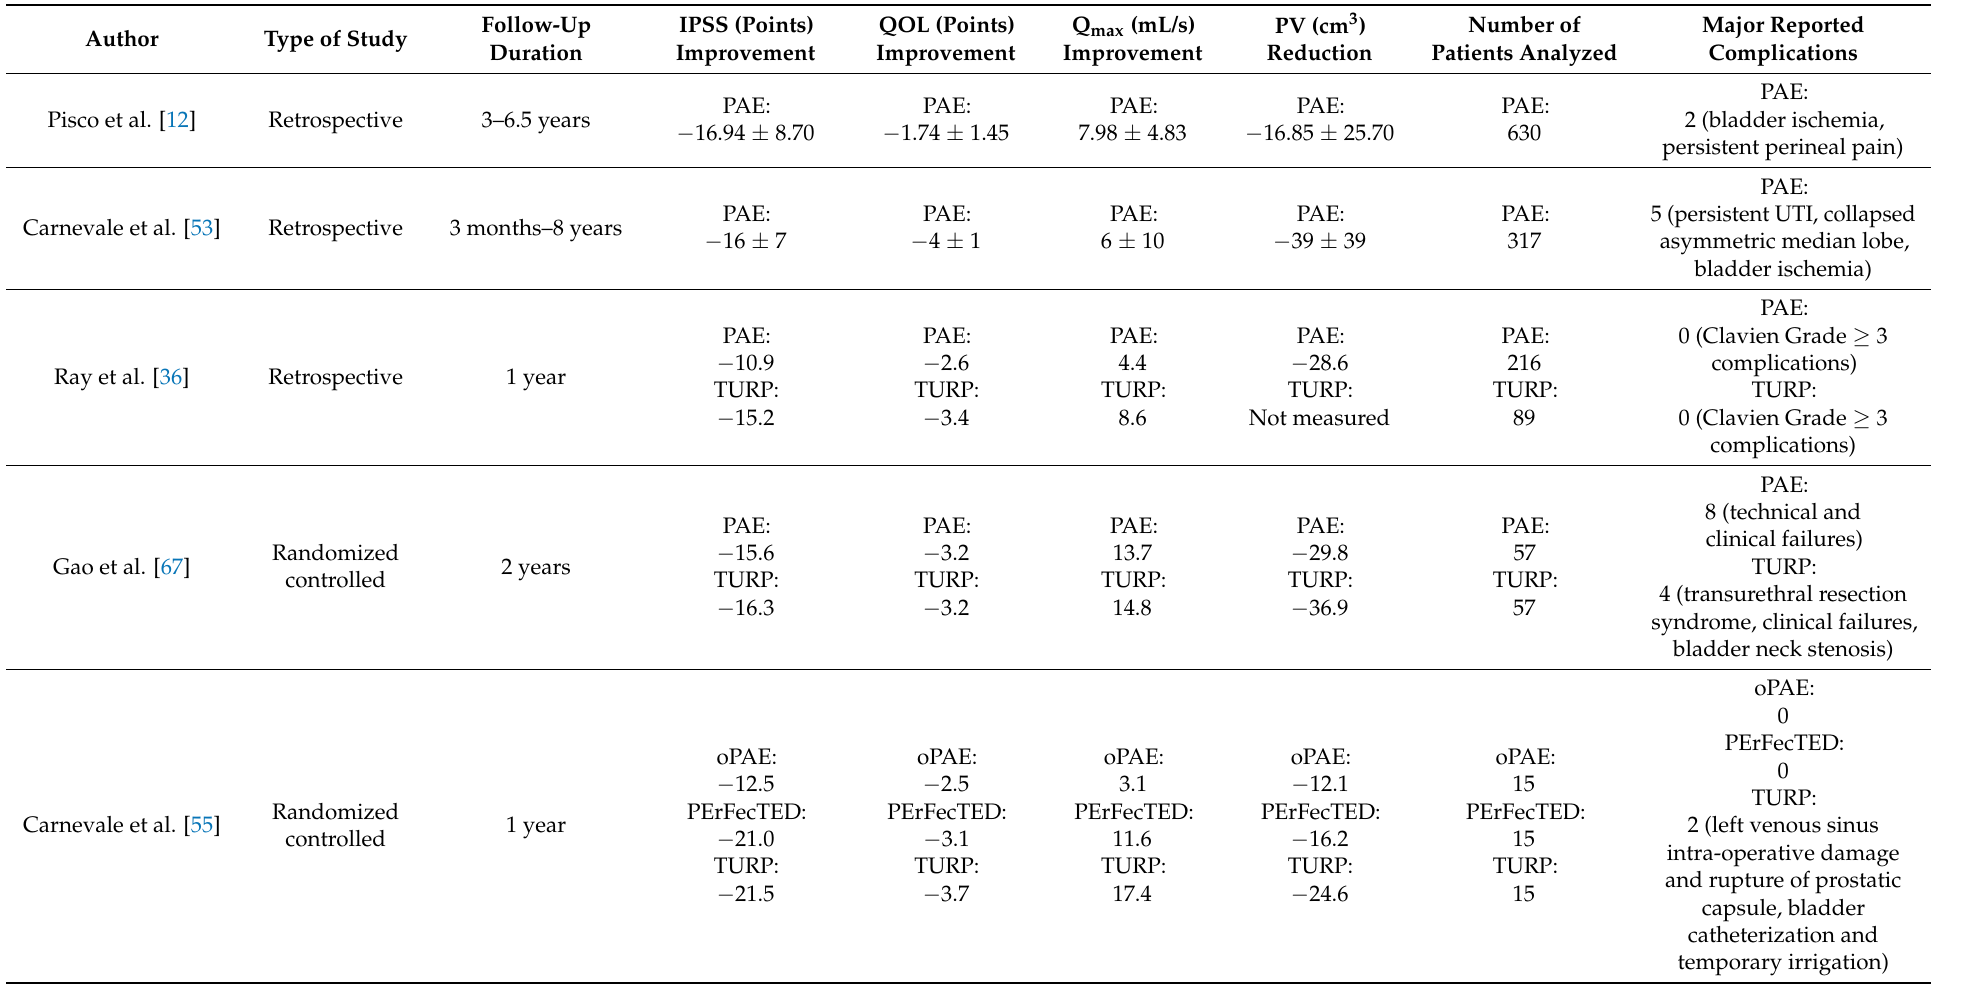
Table 2. A summary of the retrospective studies, randomized controlled trials and meta-analyses studies. A narrative review was performed to determine the safety and efficacy of PAE. Data is presented as the reported mean differences from the baseline